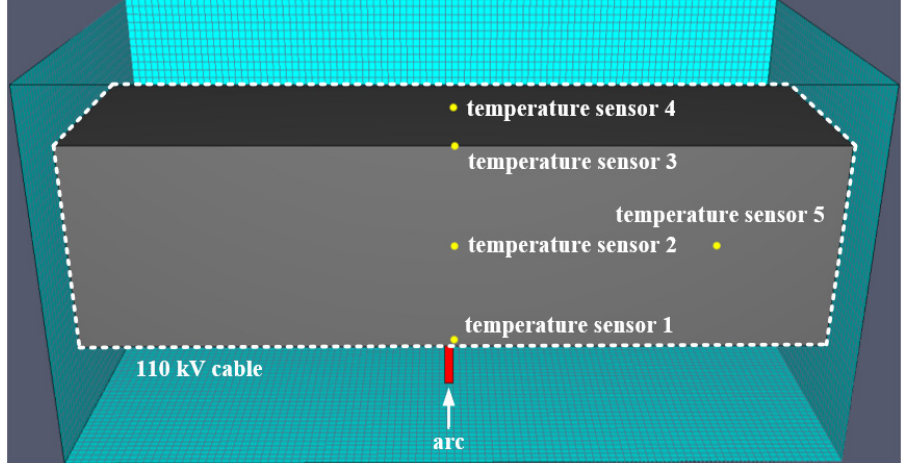
Figure 11. The model of the cable fire.